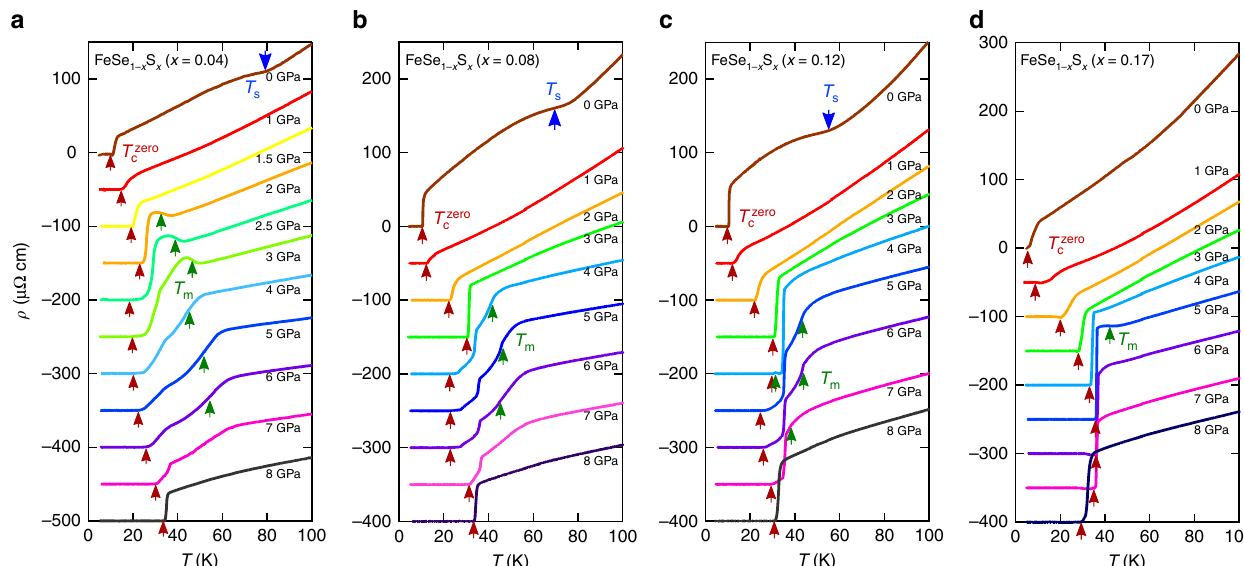
Fig. 2 Evolution of temperature-dependent resistivity under pressure in FeSe 1 − x S x . a – d ρ ( T ) curves below 100 K at different pressures up to 8.0 GPa measured for x = 0.04 ( a ), 0.08 ( b ), 0.12 ( c ) and 0.17 ( d ). The data are vertically shifted for clarity. The resistive anomalies at transition temperatures T T T zero (red) are indicated by the arrows. For x = 0.04 ( a ), the anomalies associated with the magnetic transition is smeared and s (blue), m (green) and c thus the error of T m determination is relatively large for P ≥ 4 GPa (see error bars in Fig.